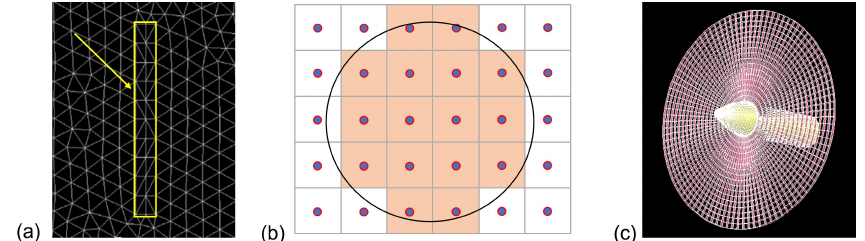
Figure 2. ( a ) SHYFEM grid details; the yellow rectangle delimits the turbine’s top view, ( b ) qualitative representation of the turbine’s frontal area in the SHYFEM z-layer discretization, and ( c ) details of a typical ANSYS Fluent grid used with